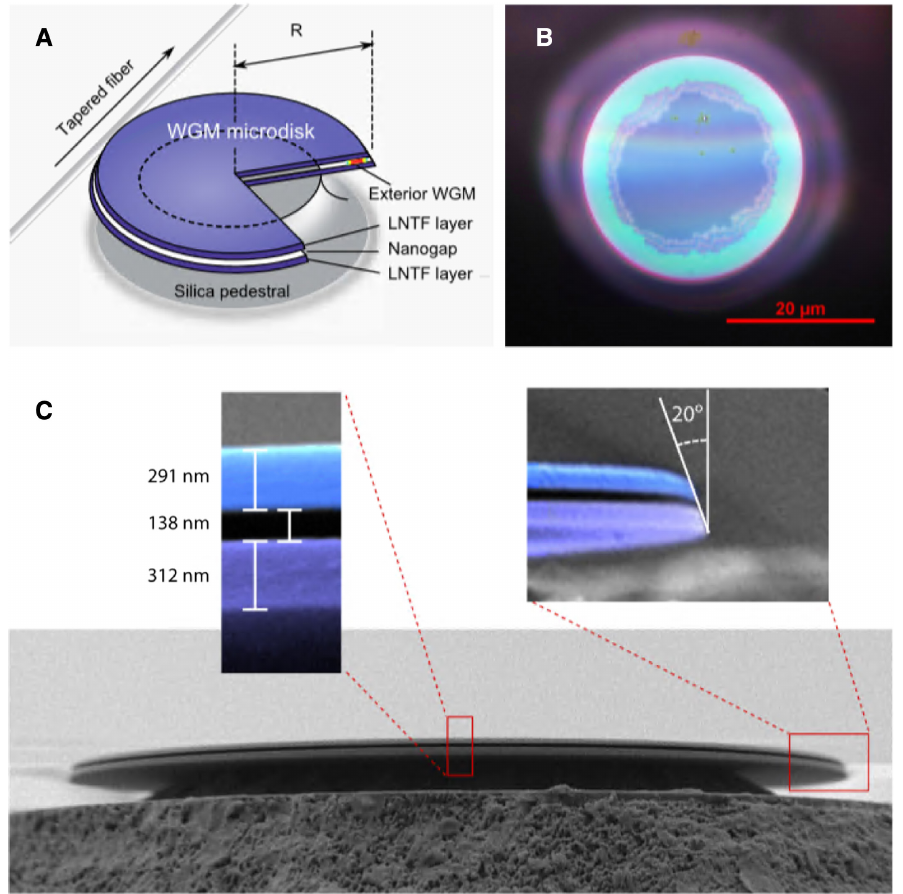
Figure 13: A double-layer LNOI microdisk resonator. (A) Schematic of the double-layer LNOI microdisk resonator. (B) Top-view optical microscopy image of the microdisk. The two inner irregularly shaped circles indicate inward etching of the silica buffer layers. (C) Scanning electron microscope image of the microdisk, with enlarged false-colored images clearly showing the well-separated upper and lower LN thin film layers. Reprinted (abstract/excerpt/figure) with permission from Zheng et al. [94]. Copyright (2019) by the American Physical Society.